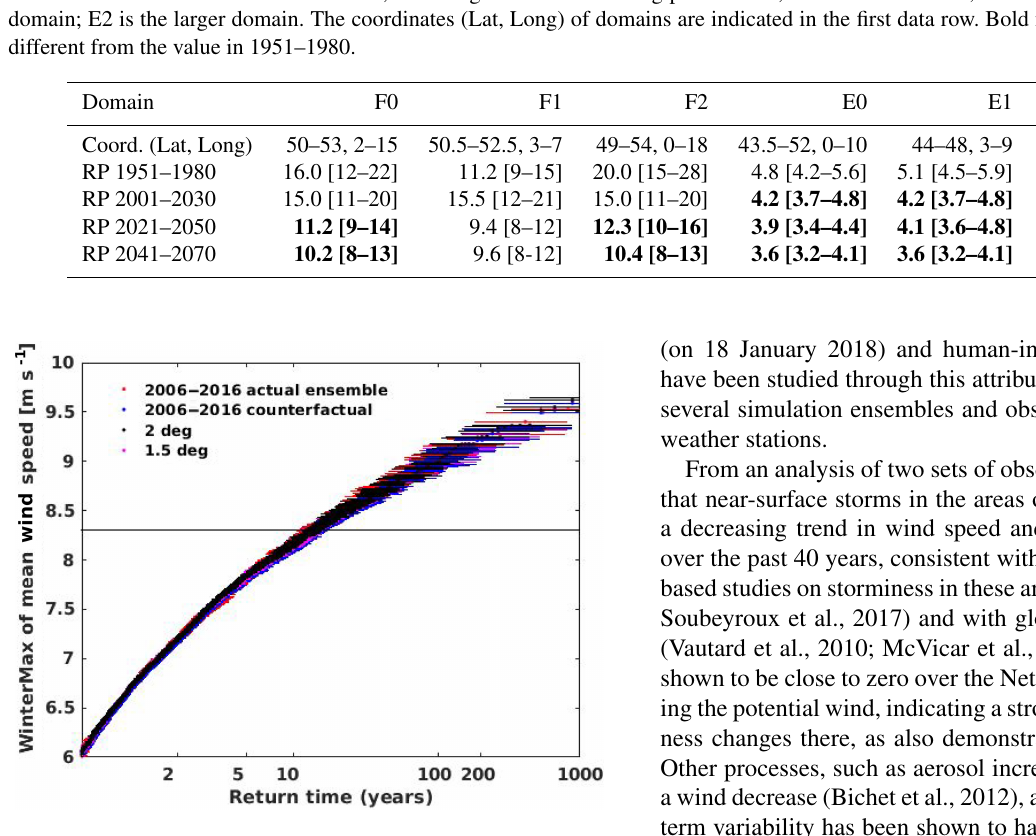
Figure 9. Return values as a function of return periods for the storm Eleanor indicator for the weather@home ensemble with 5%–95% significance intervals, calculated from a nonparametric bootstrap, under the assumptions of actual, counterfactual, 1.5 ◦ C, and 2 ◦ C